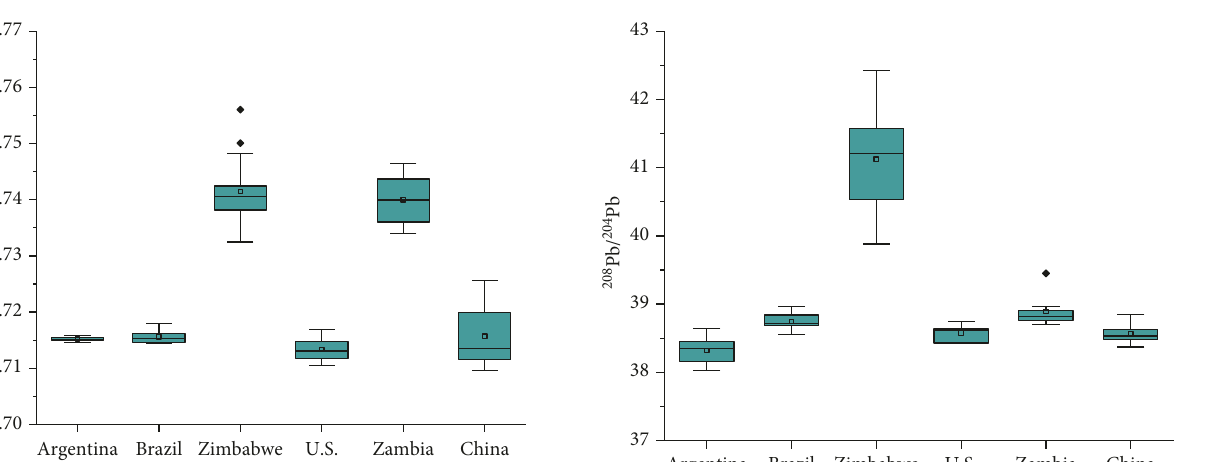
Figure 10: The box plots of 87 Sr/ 86 S isotope ratio.